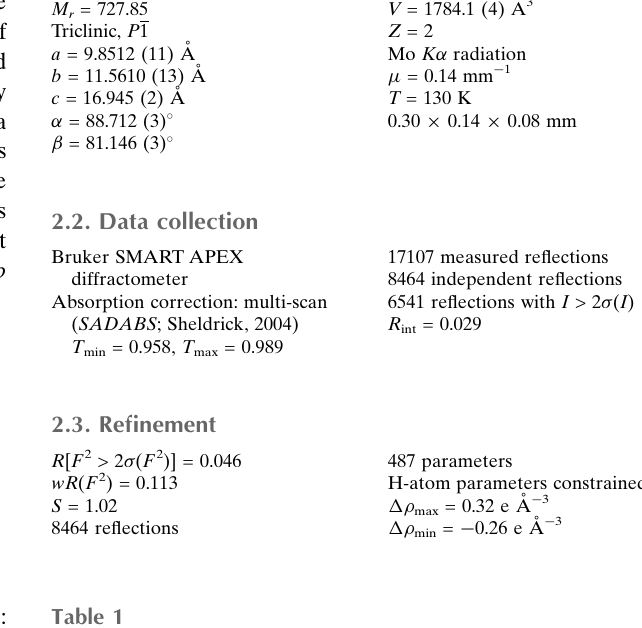
Hydrogen-bond geometry (A˚ , (cid:2)